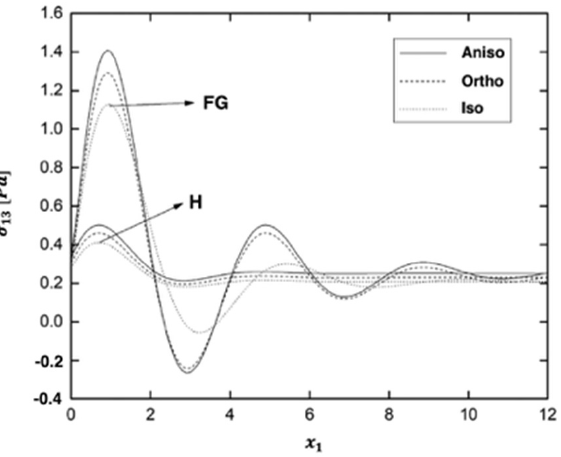
Figure 11. Variation of the thermal stress wave 𝜎 (cid:2869)(cid:2871) along 𝑥 (cid:2869) – axis in the functionally graded (FG) and homogeneous (H) fiber-reinforced plates for different materials.